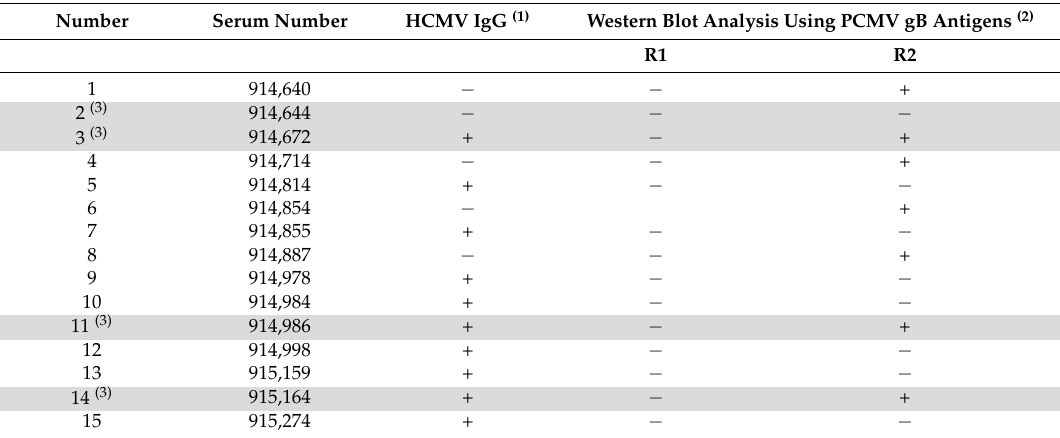
Table 3. Testing human sera for PCMV and HCMV by Western blot analysis.